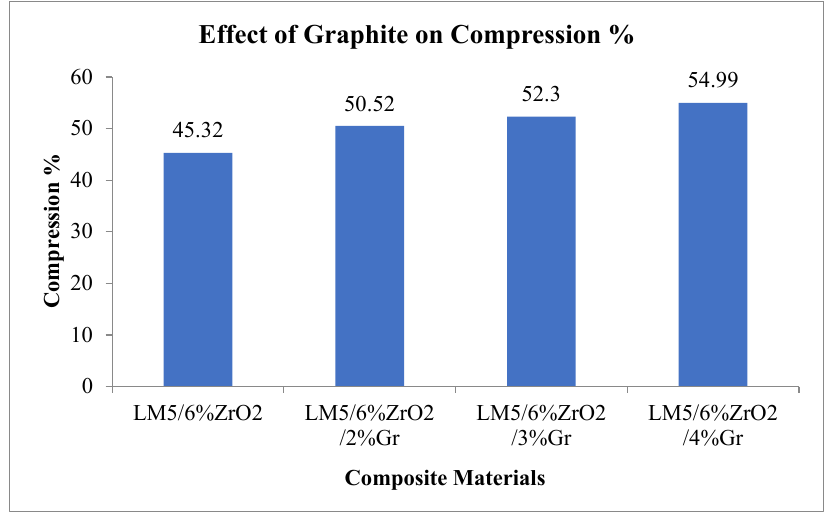
Figure 19. Effect of graphite on the compression of composites.